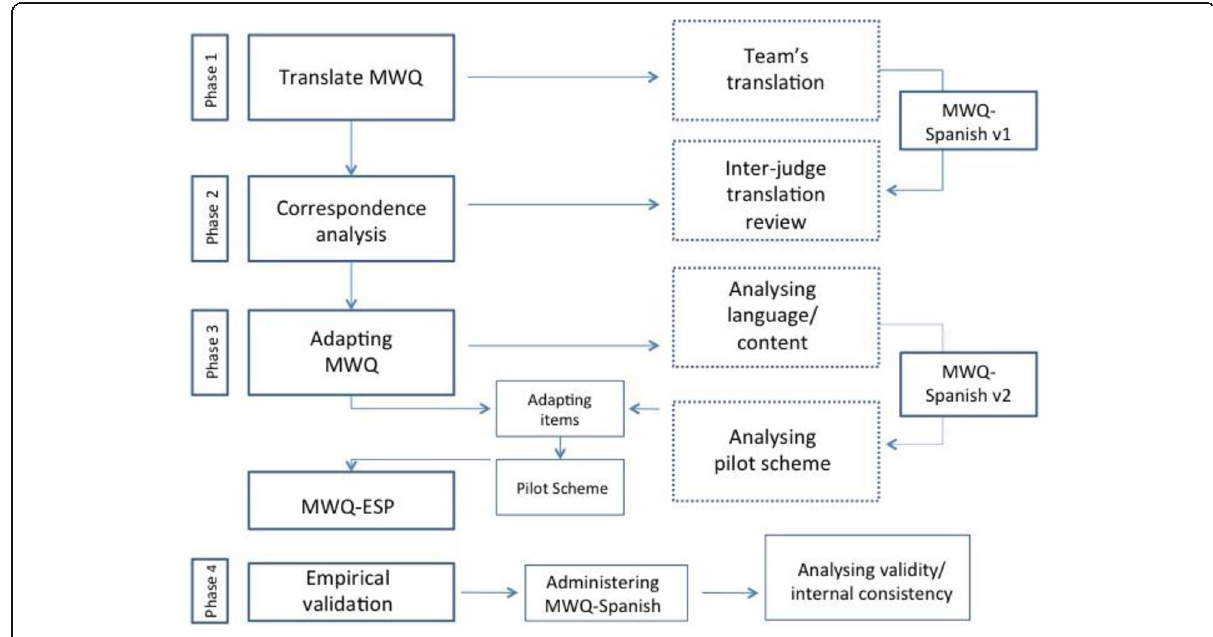
Fig. 1 Diagram showing the phases followed to adapt the